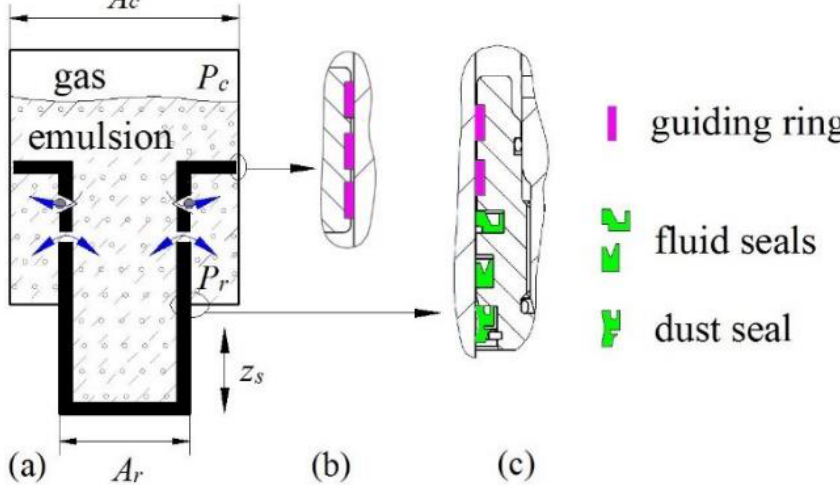
Figure 1. Mechanism of the integrated hydro-pneumatic suspension system ( a ) including the guiding rings ( b ) and rubber seals ( c ).